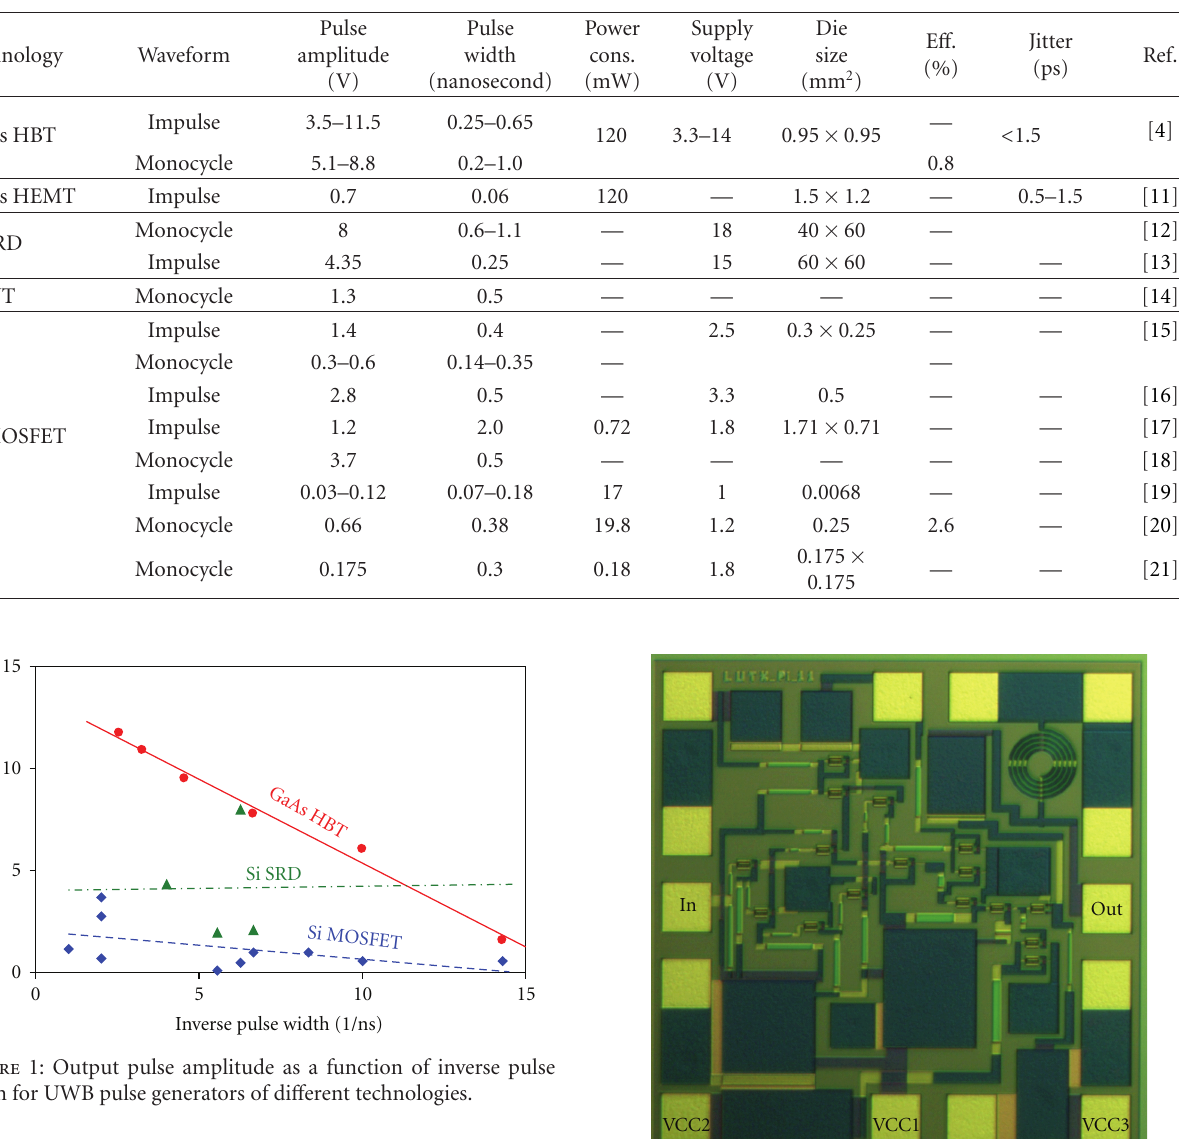
Table 1: Performance of UWB pulse generators.